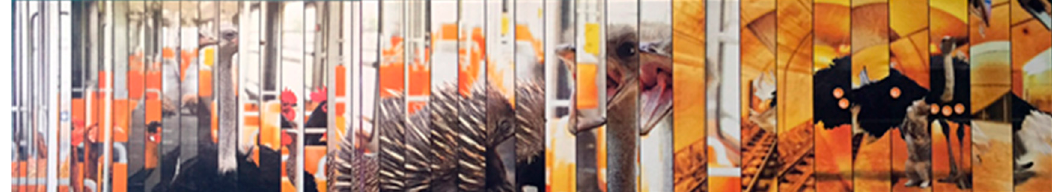
Figure 3. Exercises in Style, texticule: Permutations by Groups of 2, 3, 4, and 5 letters , developed in the Visual Design class 2016–2017 by student Sara